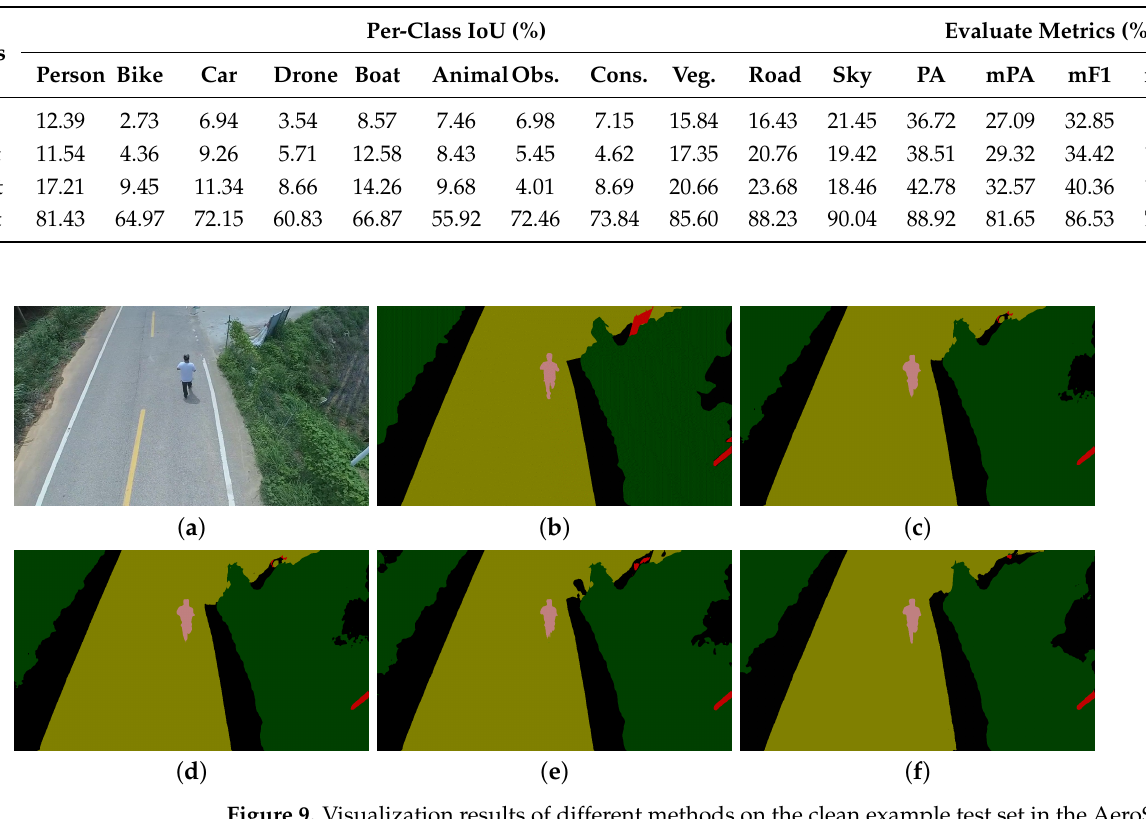
Table 6. Comparison of evaluation metrics on the adversarial example test set in the AeroScapes dataset.